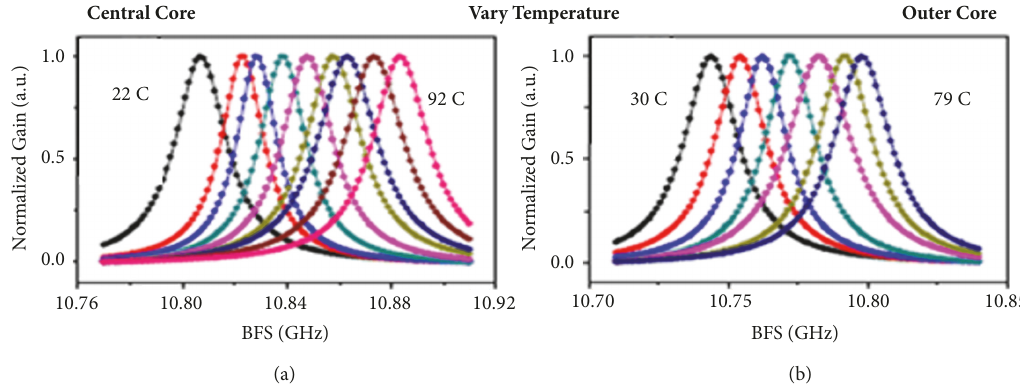
Figure 10: Comparison of SBS frequency shift as a function of temperaturein a multicore fiber, comparing the difference between the central and an outer core [adapted from